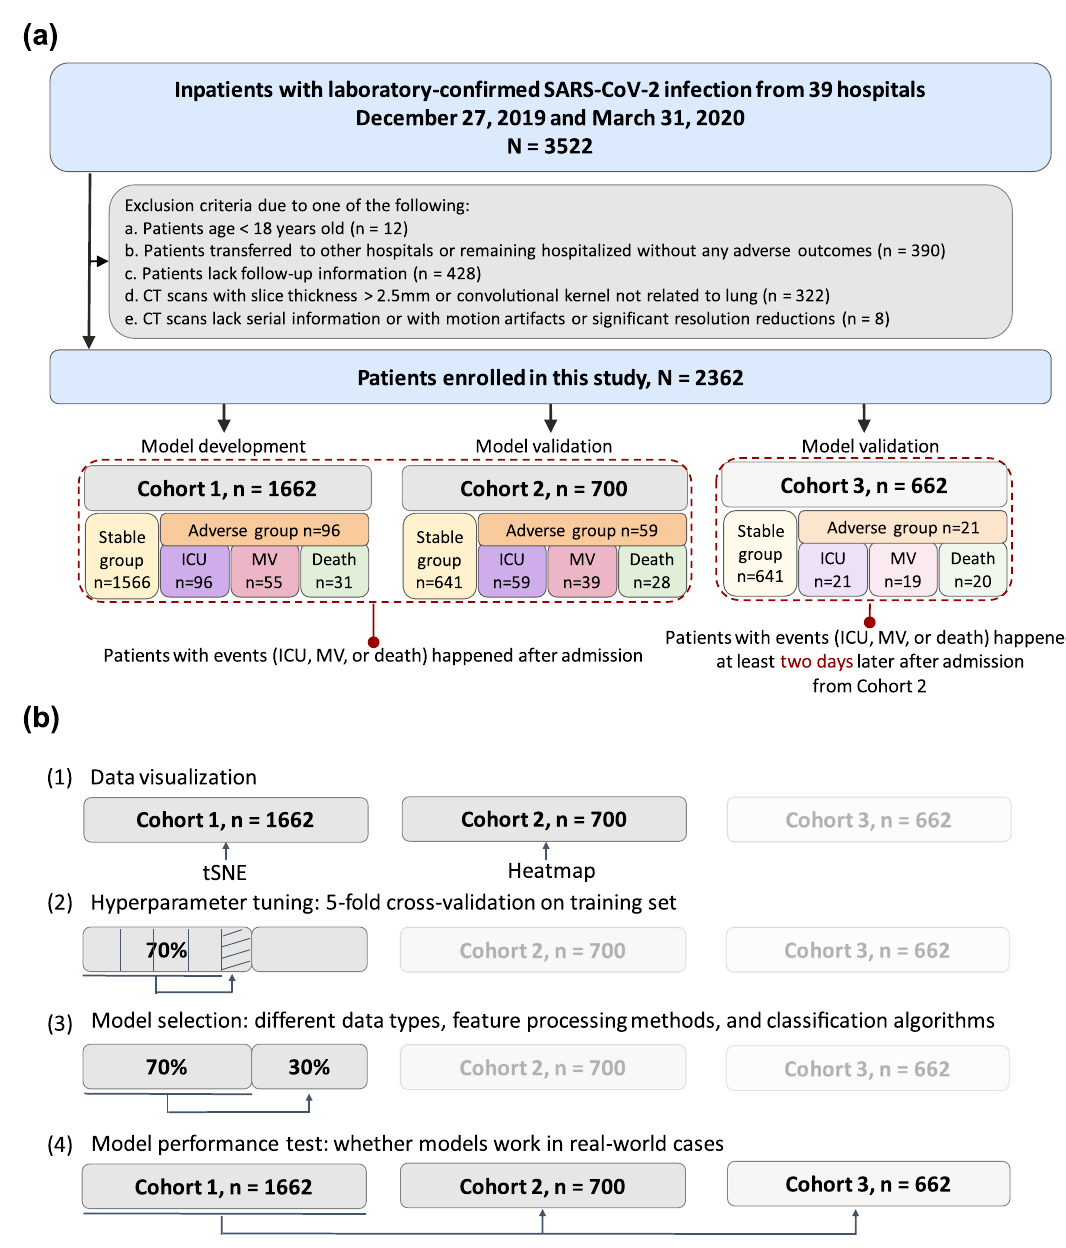
happening at least two days after admission. b Explanation of our data split and the corresponding usages. (1) Step one: feature visualization of Cohort 1 and Cohort 2 to get the preliminary intuitive sense; (2) Step two: 70% samples of Cohort 1 were picked as the training set using strati fi ed sampling based on death cases, where fi vefold cross-validation was used to tune the hyperparameters of the models; (3) Step three: model selection was performed on the remaining 30% samples of Cohort 1; (4) Step four: Cohort 2 and Cohort 3 were used to evaluate model performance in different